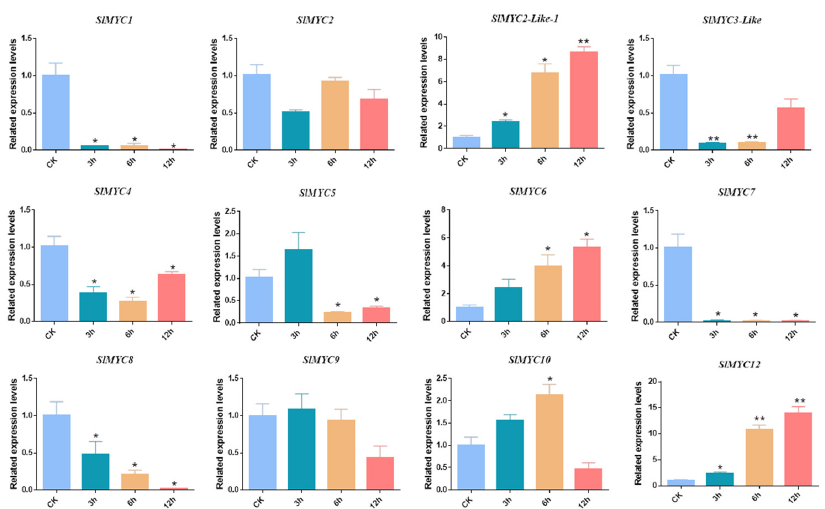
Figure 8. Response analysis of SlMYC genes in tomato leaves under mannitol by qRT-PCR. The expression patterns of SlMYC in response to 100 mM mannitol treatment for 3 h, 6 h, and 12 h. Data represent the means of three biological replicates ±SD. Different colors were used to indicate different treatment times ( p -values less than 0.05 are summarized with one asterisk, and p -values less than 0.01 are summarized with two asterisks).